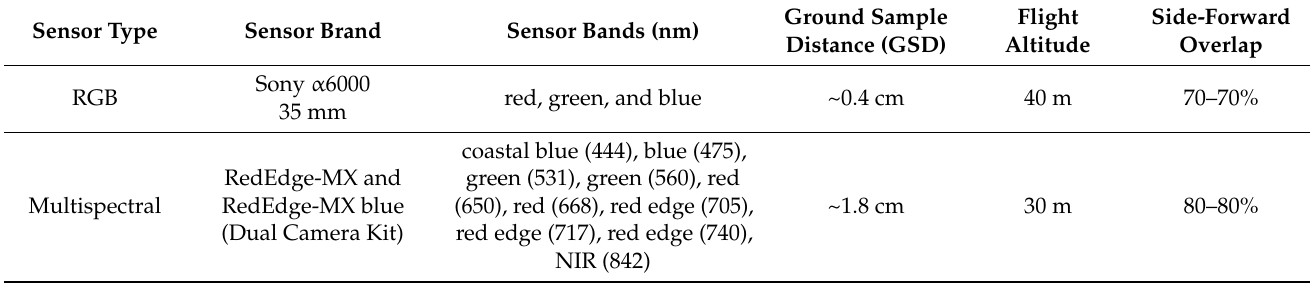
Table 1. Unmanned aerial vehicle (UAV) data acquisition details.